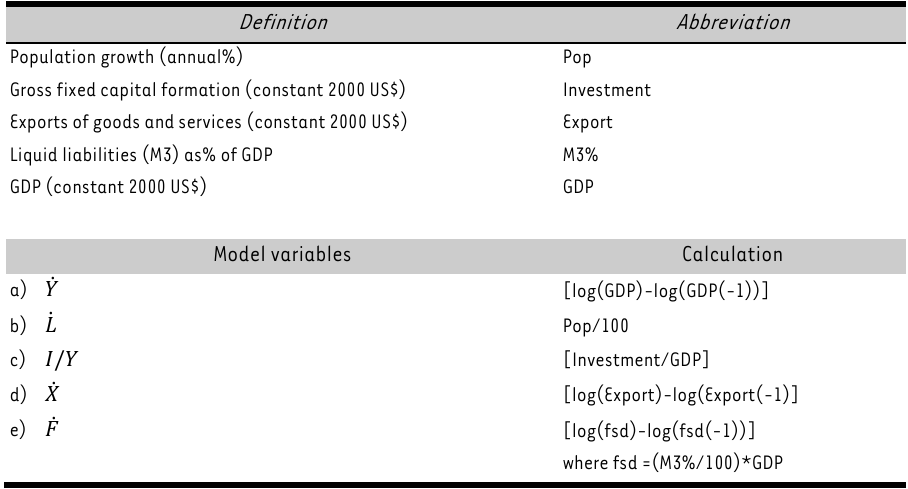
Variables from World Bank 2006